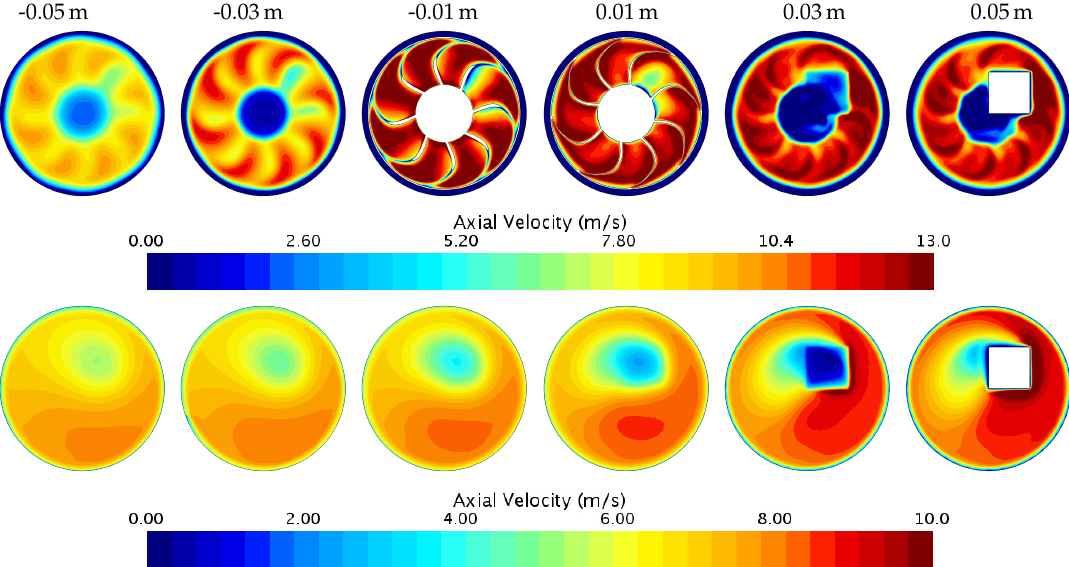
Figure 11. Influence of a box placed downstream of the MRF region with ( upper row ) and without blades ( lower row ) on the axial velocity field from 0.05m upstream ( left ) to 0.05m downstream ( right ) of the